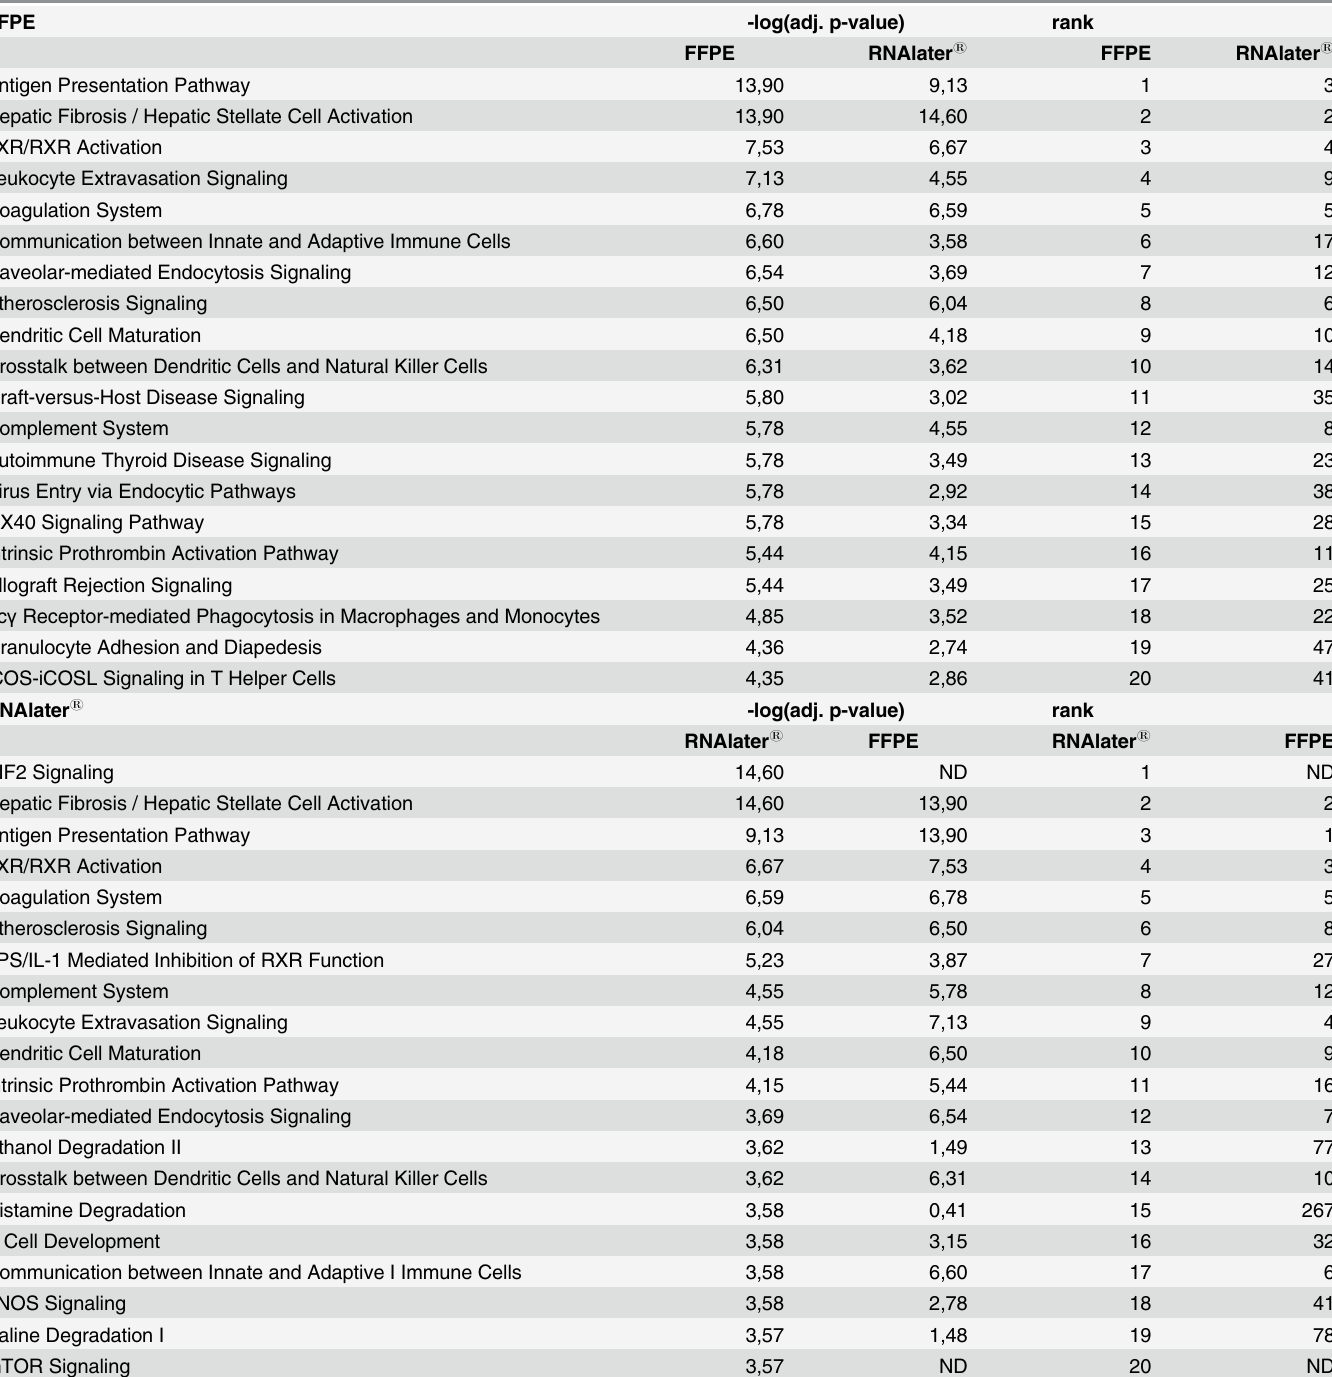
Table 3. Pathway analysis. The 20 most affected canonical pathways in each NGS dataset with the corresponding values and ranks. Rank indicates the place of the pathway within the list of pathways sorted by largest to smallest – log(adjusted p-value). 12 of 20 pathways are shared between both